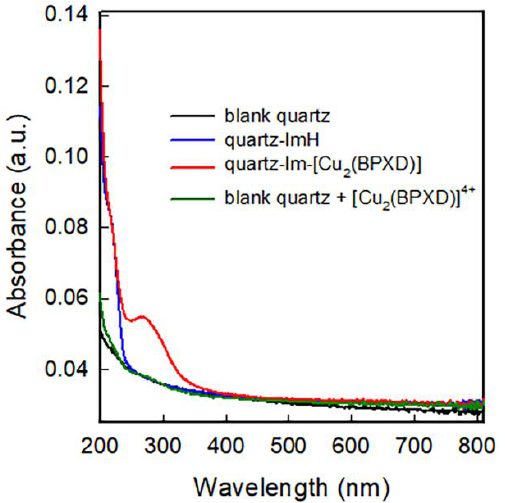
Figure 4. UV-vis spectra of a blank quartz (black line), a quartz-ImH sample (blue line), a quartz- Im-[Cu 2 (BPXD)] sample (red line) and of a blank quartz after immersion in a [Cu 2 (BPXD)](CF 3 SO 3 ) 4 solution (dark-green line).